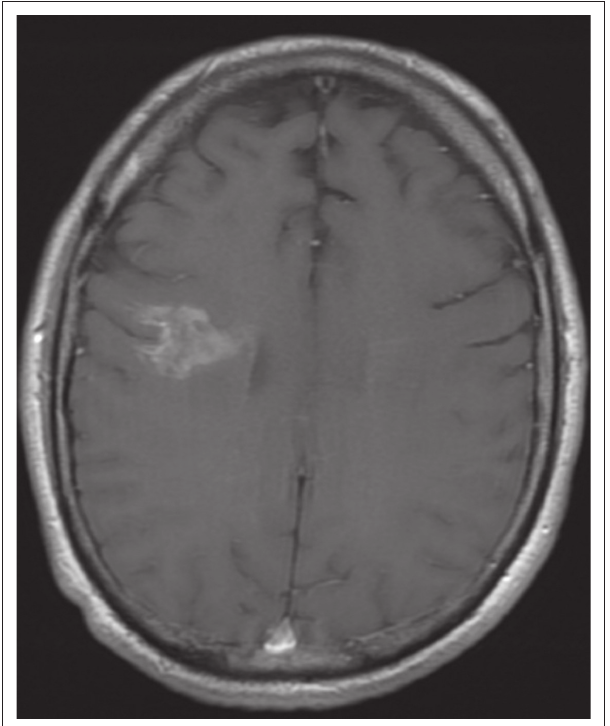
FIGURE 5: Axial post contrast T1-weighted MR image